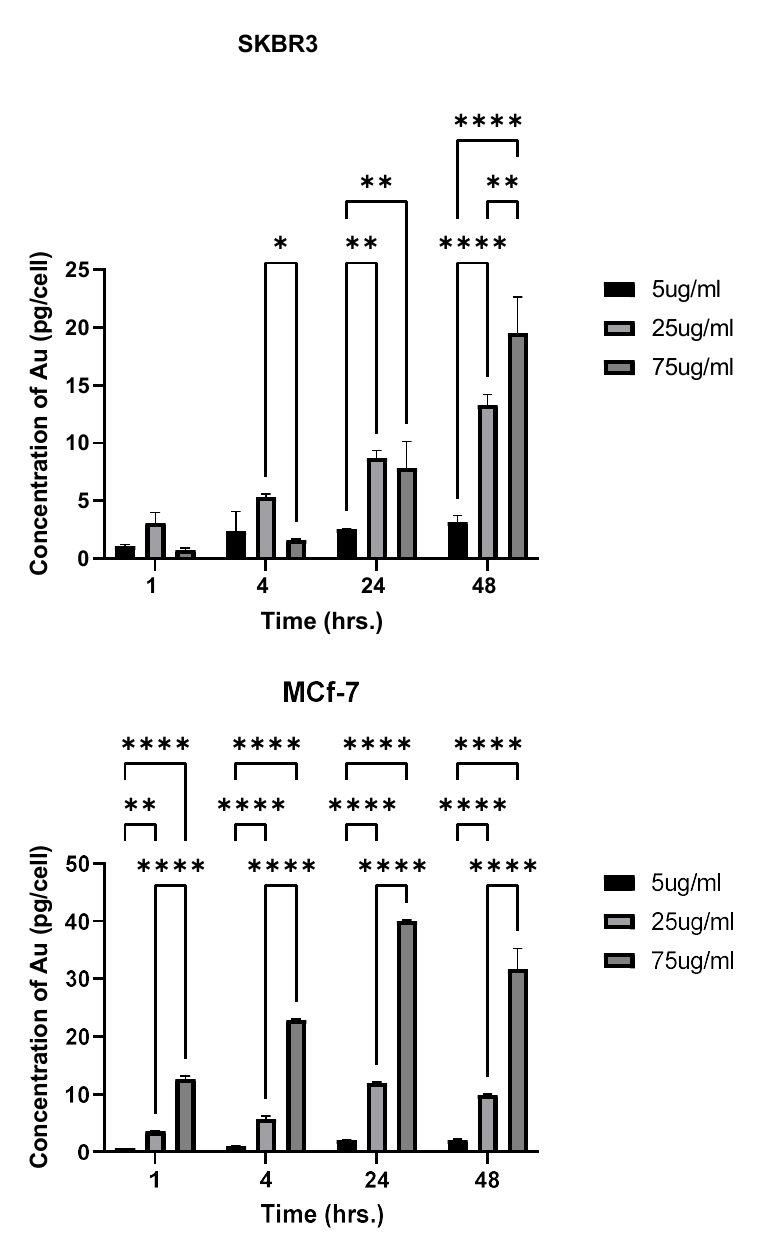
Figure 3. Uptake differences based on concentration: cellular uptake of AuNRs in SKBR-3 ( top ) and MCF-7 ( bottom ) cells at different time points, as analyzed by inductively coupled plasma mass spectrometry. Statistical differences between time points in a single concentration were determined based on p < 0.05. No differences were observed between concentrations at 1 h in SKBR-3. At 4 h with the 75 µ g/mL concentration, there was not much change in accumulation. Differences were observed in MCF-7 at 1 h with all concentrations of AuNRs. MCF-7 also showed a difference between all concentrations at 4 h and 24 h, but this was not the case in SKBR-3. At 48 h, there was a significant difference in cellular uptake between all concentrations in both cell types (* indicates a p-value of less than 0.05, ** less than 0.005, **** less than 0.00005 etc.). Most importantly, with respect to cellular uptake, when comparing the two cell lines, we observed a greater amount of nanorods taken up in SKBR-3 cells at 48 h of exposure, and concentrations of 5 and 25 µ g/mL. Interestingly, this trend changed with a AuNR dose of 75 µ g/mL, at which point MCF-7 showed greater nanorod uptake at all time points, except 48 h. At 48 h, there was no longer a difference in uptake by the two cell